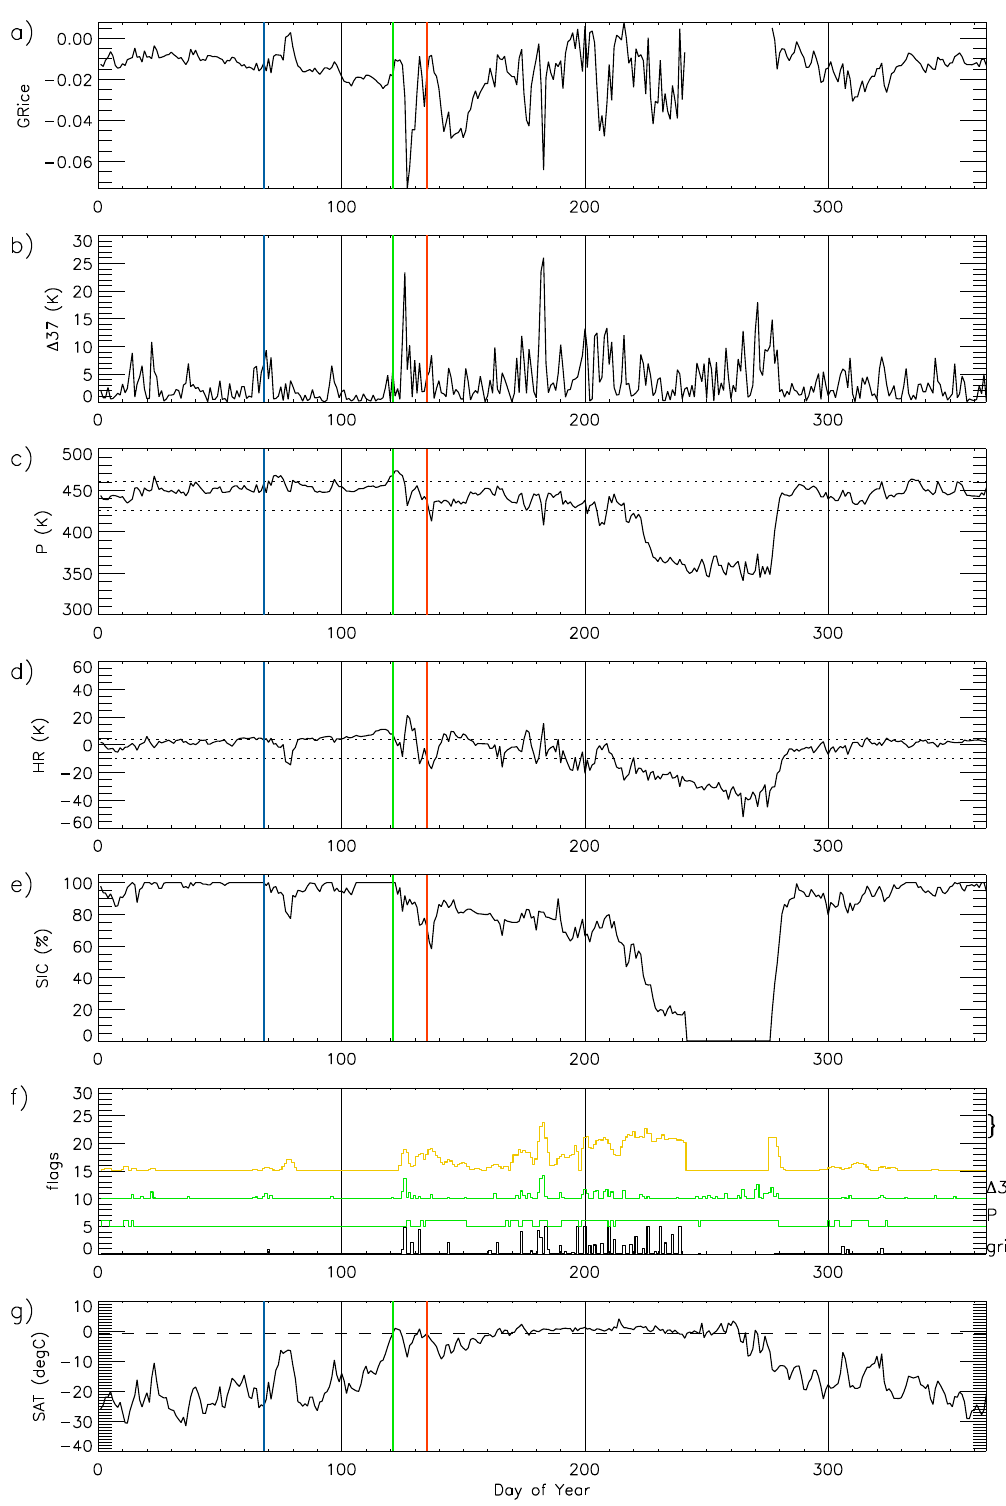
Figure 2. PMW MO parameters (( a ) Δ GR ice , ( b ) Δ 37V, and ( c ) P), ( d ) AHRA HR, ( e ) NASA Team sea ice concentration, ( f ) PMW weighting flags (see text for details), and ( g ) POLES SAT from 1992 for case study location in the Barents Sea (78.3°N, 62.7°E). MO dates from AHRA (blue), PMWC (red), and first instance of SAT >0 °C (green) are shown as vertical lines.